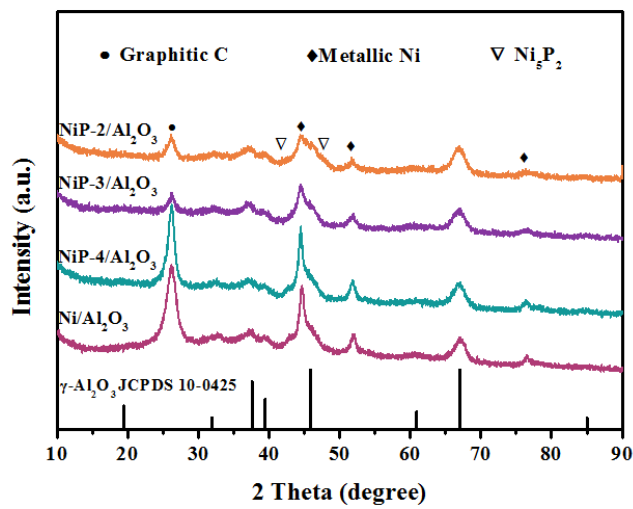
Figure 9. XRD patterns of spent Ni/Al 2 O 3 and NiP-x/Al 2 O 3 catalysts.